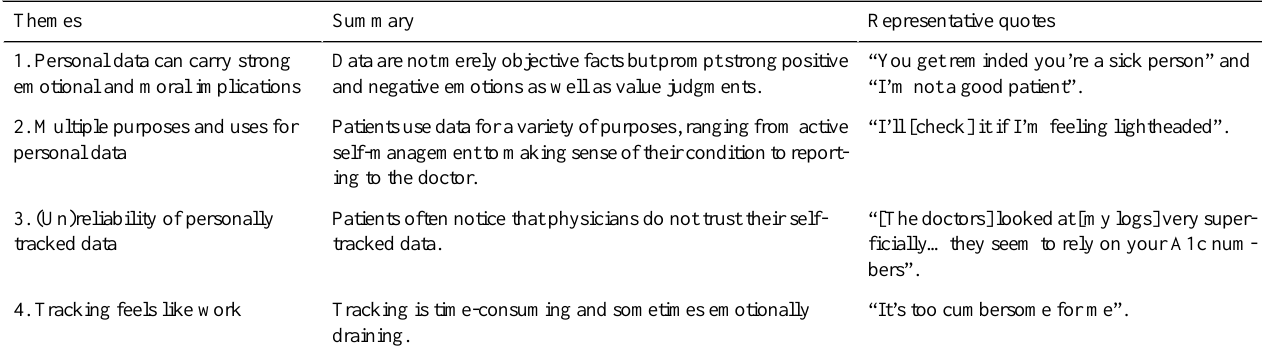
Table 1. Major themes in personal health information